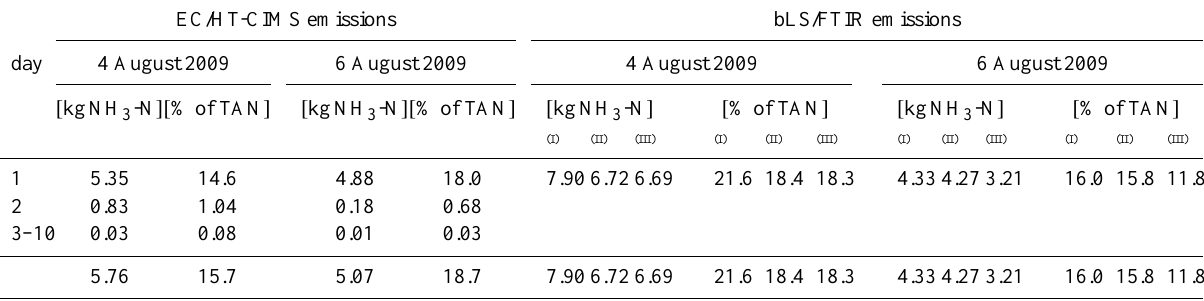
Table 4. Cumulated field emissions calculated by EC/HT-CIMS and by bLS/FTIR on (I) lower, (II) middle and (III) upper measurement height.